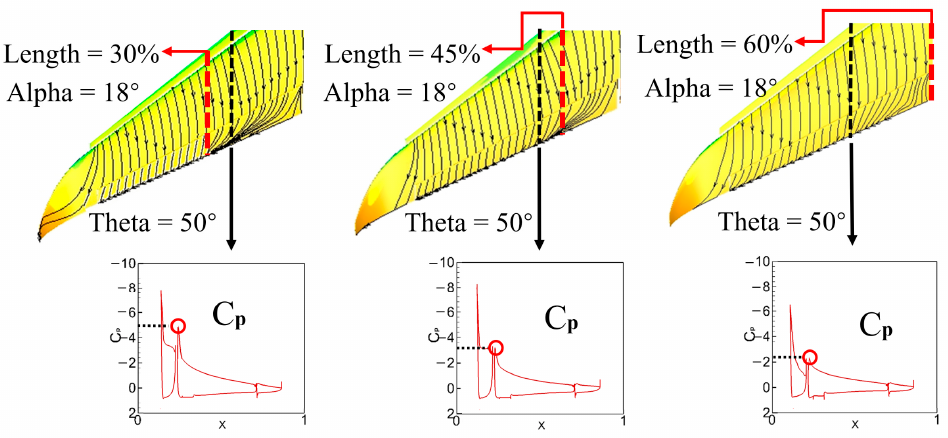
Figure 17. Upper surface limiting streamlines; the local pressure distribution of the sensitivity analysis of length.